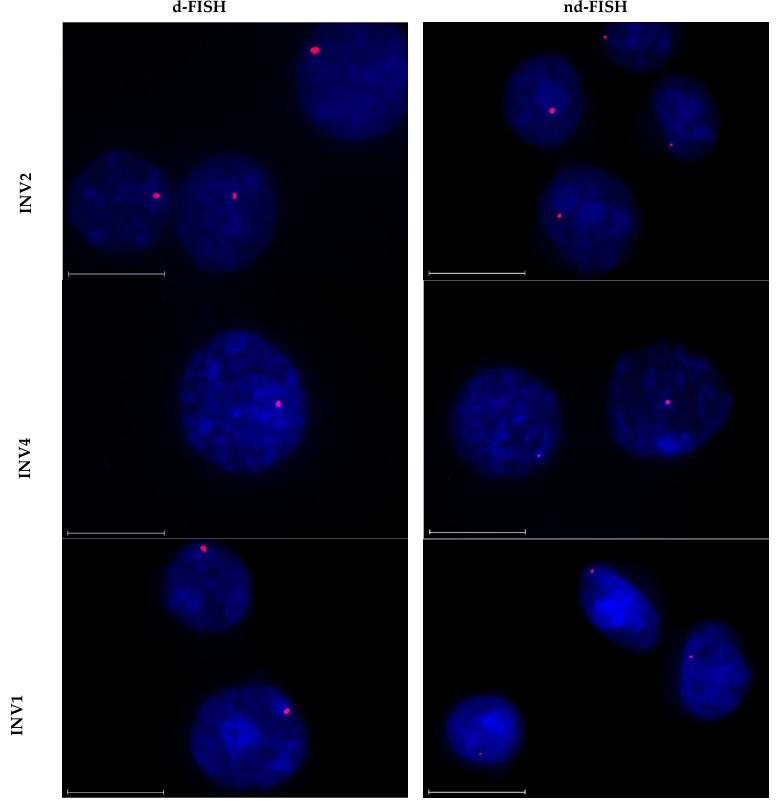
Figure 6. Representative images from FISH experiments in which DYZ1 -targeting Invader probes INV2 , INV4 , and INV10 (upper, middle and lower panels, respectively) were incubated with isolated nuclei from a bovine kidney cell line under denaturing (5 min, 80 °C, left) or non-denaturing (3 h, 37.5 °C, right) conditions. Fixed isolated nuclei were incubated with probes in a Tris buffer (20 mM of Tris-Cl, 100 mM of KCl, pH 8.0) and counterstained with DAPI. The images were obtained by overlaying Cy3 (red) and DAPI (blue) filter settings and adjusting the exposure. Nuclei are viewed at 60× magnification using a Nikon Eclipse T i -S inverted microscope. The scale bar represents 16 µm. For corresponding images for other Invader probes, see Figures S14 – S17.